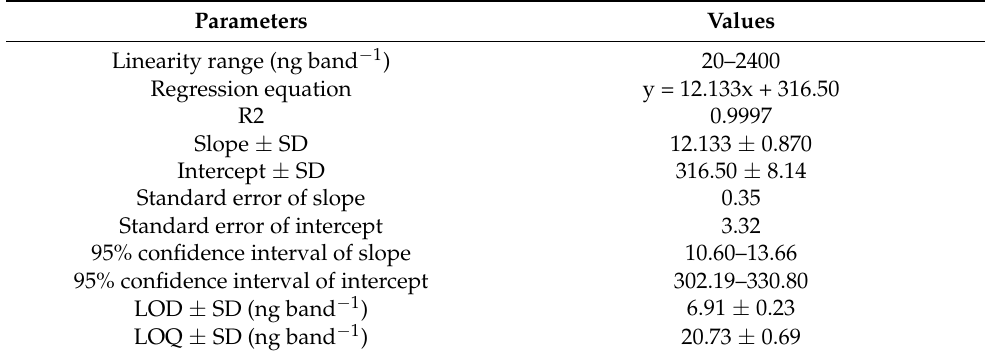
Table 1. Results for least-squares regression analysis for the determination of hydroquinone (HDQ) using an ecologically sustainable high-performance thin-layer chromatography (HPTLC) method (mean ± SD; n = 6).